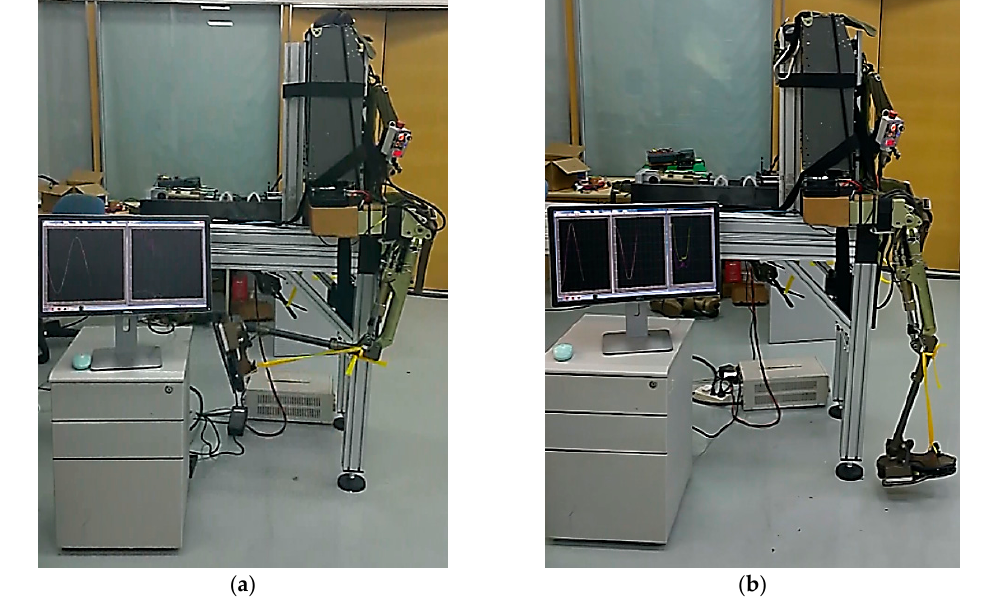
Figure 6. Data acquisition of APAL: ( a ) Hip joint was fixed and knee joint swung; ( b ) Hip and knee joints swung.